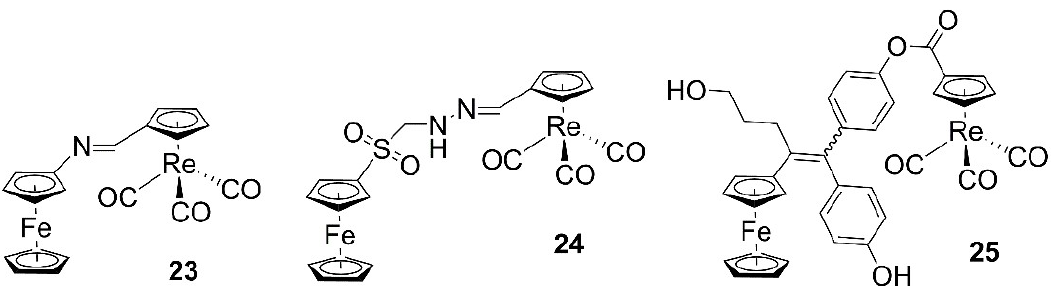
Figure 4. Structures of heteronuclear iron-rhenium anticancer complexes.